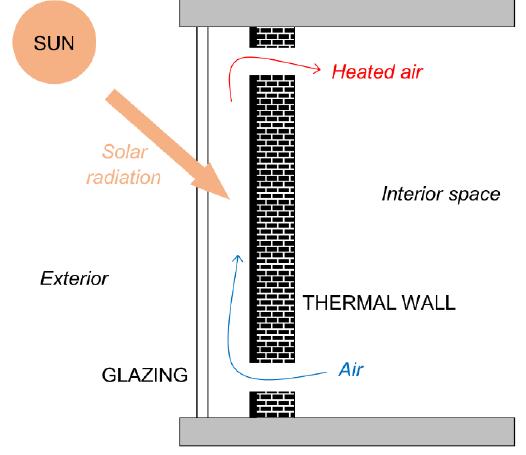
Figure 3. Schematic of a classic Trombe wall.